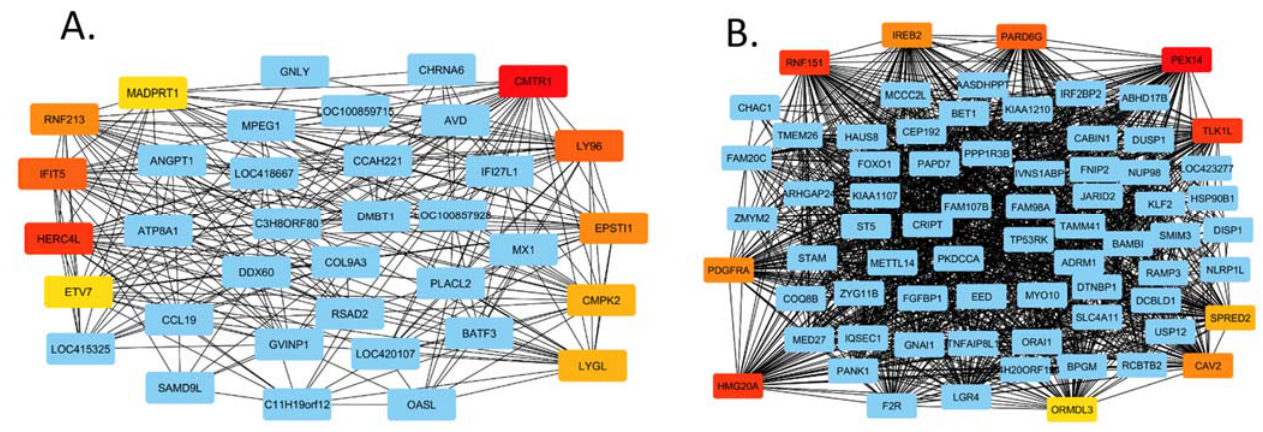
Figure 6. Cytoscape gene networks of the up-regulated HPAI dataset ( A ) and down-regulated HPAI dataset ( B ).